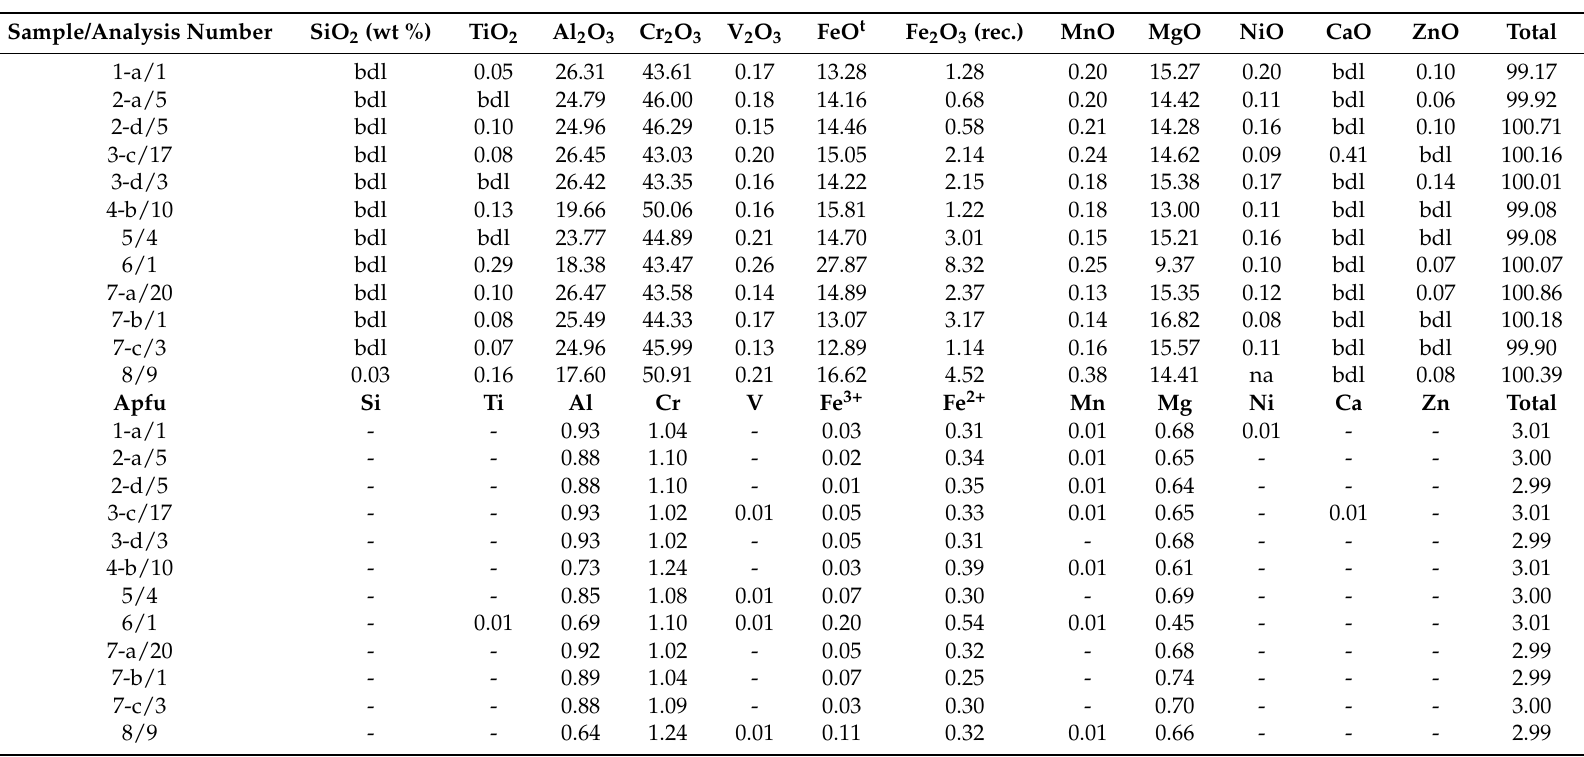
Table A2. Electron-microprobe analyses and structural formulae (on the basis of 4 atoms of O) of Cr-spinel. Fe 2 O 3(rec.) is not included in the Total of each analysis. Abbreviations: bdl = below detection limit; na = not